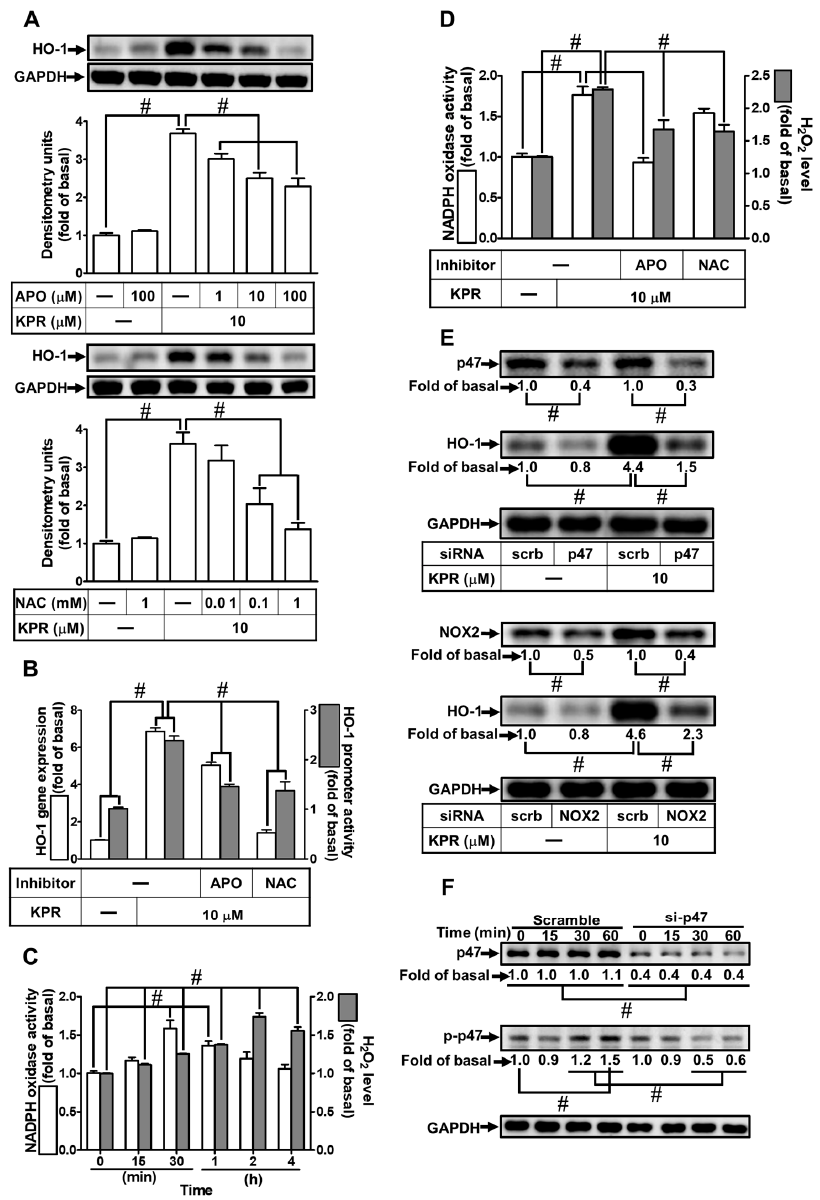
Figure 4. NADPH oxidase activation and ROS generation by KPR regulate HO-1 expression. ( A ) HPAEpiCs were pretreated with various concentrations of APO or NAC for 1 h and then incubated with vehicle or KPR (10 µ M) for 16 h. The protein expression of HO-1 was determined by Western blot using GAPDH as a loading control. ( B ) Cells were pretreated with or without APO (100 µ M) or NAC (1 mM) for 1 h, and then incubated with DMSO or KPR (10 μ M) for 6 h or 8 h. The HO-1 mRNA expression and promoter activity were analyzed by real-time PCR (6 h) and promoter activity assay (8 h), respectively. ( C , D ) The chemiluminescence was measured for NADPH oxidase activation and ROS accumulation. Cells were treated with KPR (10 μ M) at the indicated time intervals. ( D ) Cells were pretreated with APO (100 μ M) or NAC (1 mM) for 1 h and then incubated with KPR (10 μ M) for the indicated time intervals (30 min for NADPH oxidase activation; 2 h for ROS). ( E ) Cells were transfected with p47 or NOX2 siRNA, and then incubated with KPR (10 μ M) for 16 h. The protein levels of HO-1, p47, NOX2, and GAPDH were determined by Western blot. ( F ) Cells were pretreated with p47 siRNA, and then incubated with KPR (10 μ M) for the indicated time intervals. The levels of phospho-p47 and total p47 were determined by Western blot. Data are expressed as mean ± SEM ( n = 5), analyzed with one way ANOVA and Dunnett’s post hoc test. # p < 0.01, as compared with the cells exposed to vehicle alone; or significantly different as